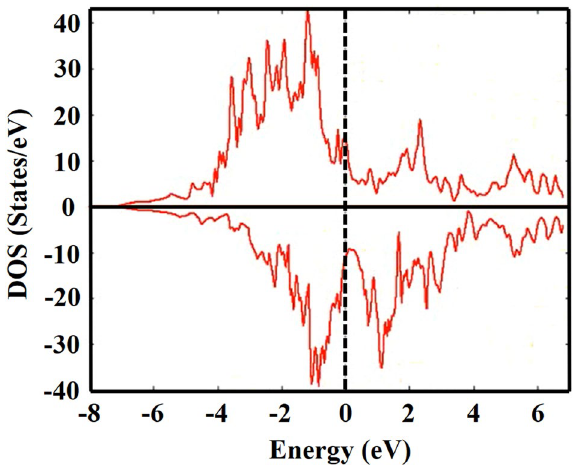
Figure 2. The spin-up and spin-down electronic density of states (DOS) for HoFe 3 .